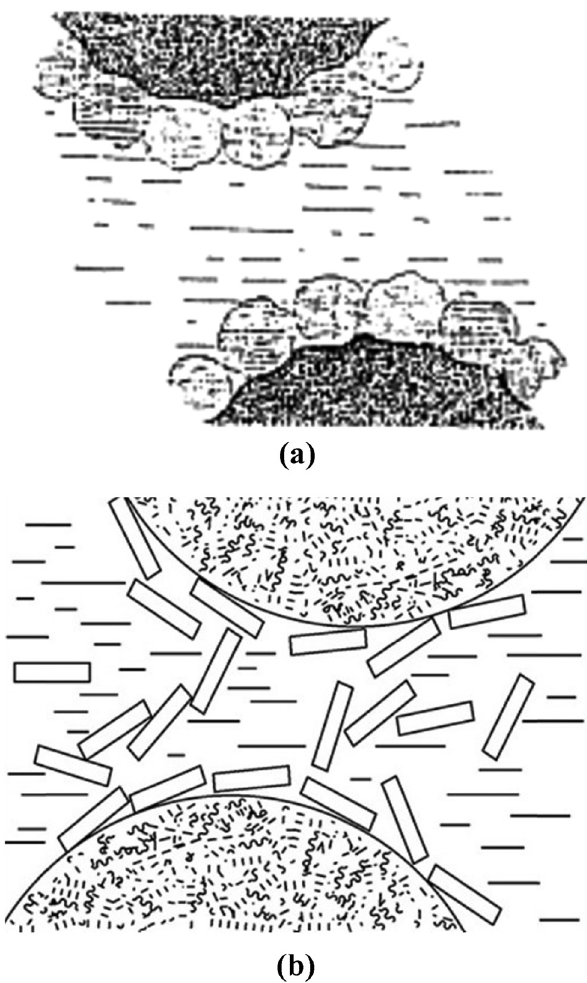
Figure 3: Stability mechanism of Pickering emulsion [ 38 ] . ( a ) Mechanical barrier mechanism and ( b ) three - dimensional viscoe - lastic particle network